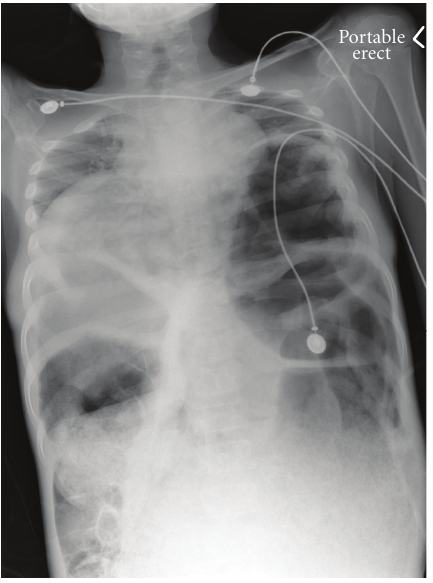
Figure 2: Chest X-ray performed just prior to intubation. Marked elevation of the heart and diaphragm with decreased lung volumes and compressed